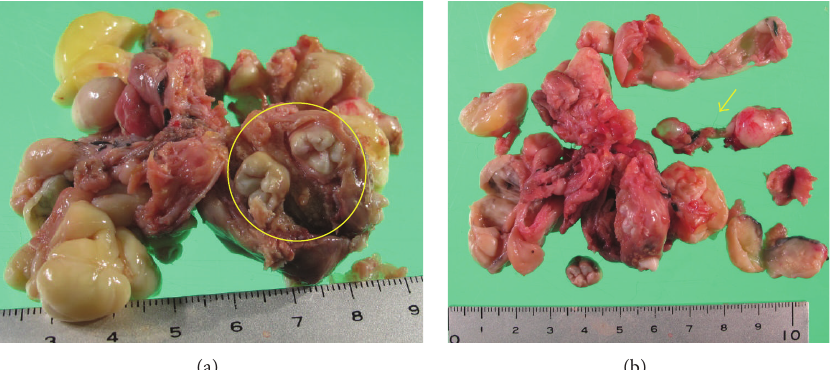
Figure 3: (a) Resected tumor (7.0 × 6.5 × 2.5 cm) and (b) cut surfaces. The tumor was multilobular and contained teeth, gingiva (circle), and hair (arrow).